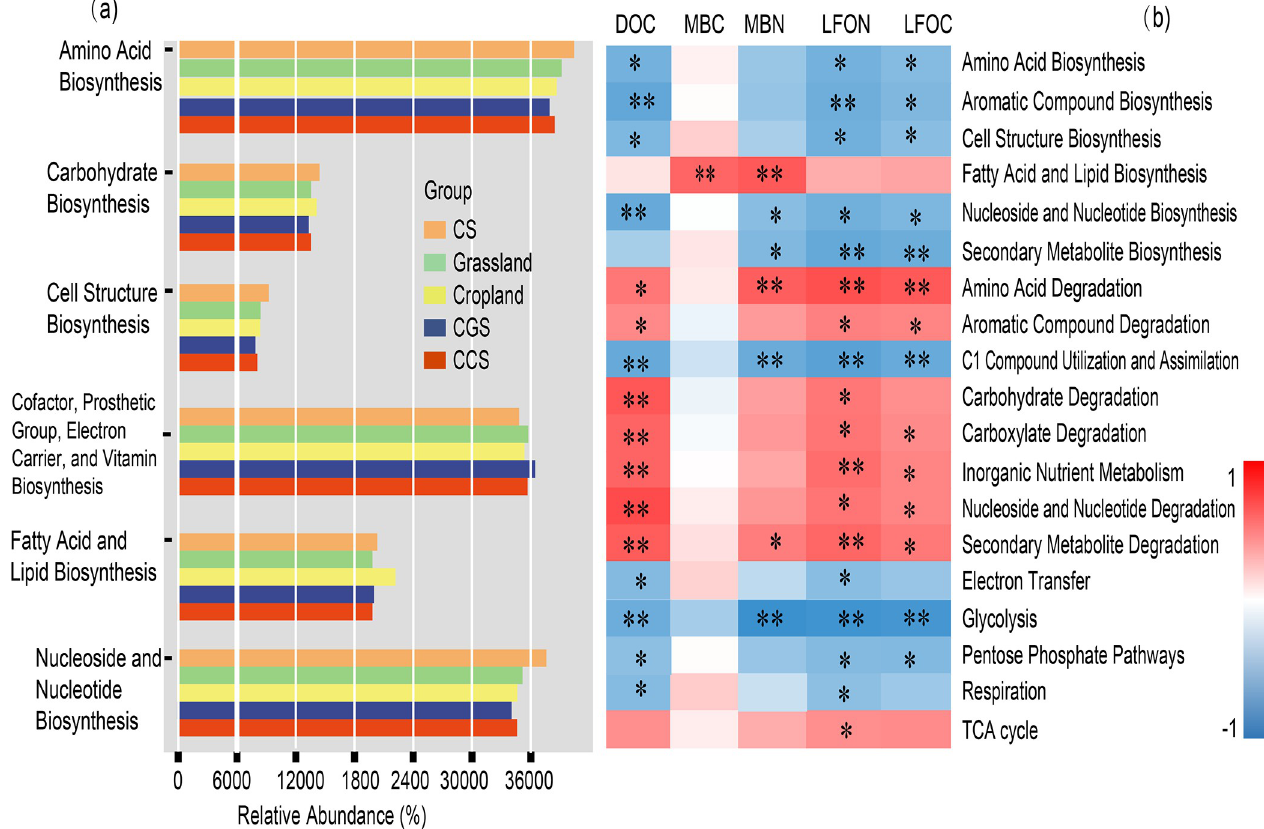
Fig 4. Bacterial relative abundance of main biosynthesis function (a) and the Pearson correlation analysis between OM fractions and major microbial functional genes (b). The “ ** ” meant significance was less than 0.01, and “ * ” meant significance was less than 0.05.in the five soil types.